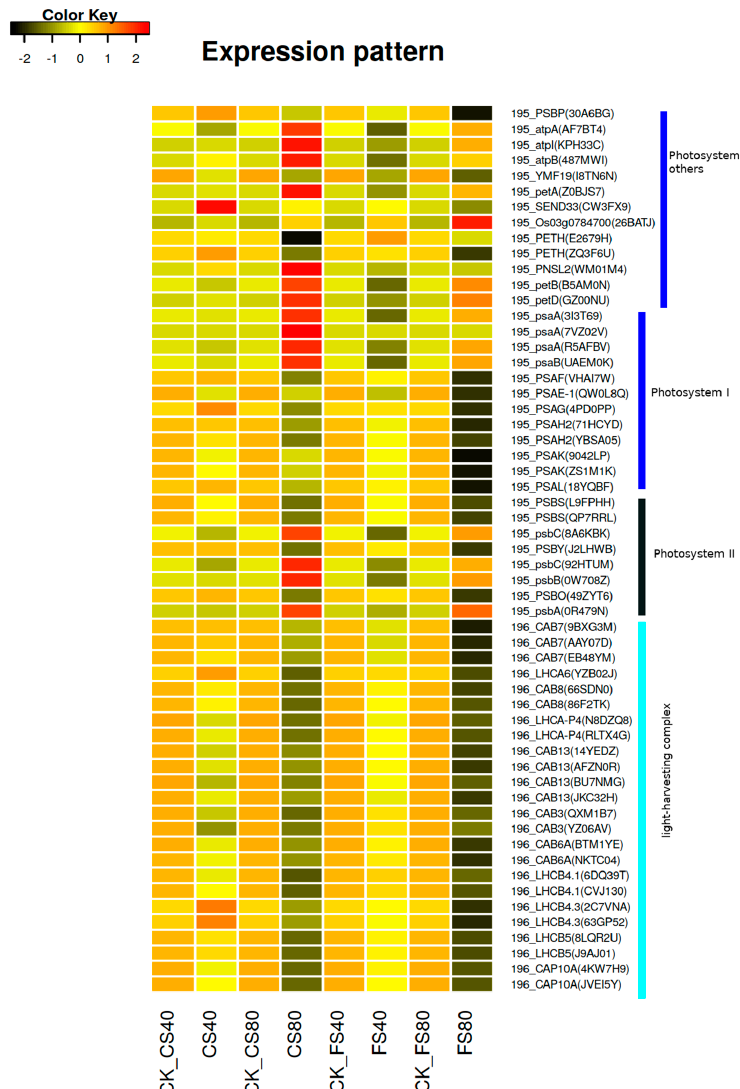
Figure 6. Expression patterns of DEGs induced by shade stress in photosynthesis pathways. The heatmap showing expression levels of differentially expressed genes (DEGs) induced by shade treatments in leaves of peanut plants. The expression level of each gene was calculated as fragment per kilobase per million reads (FPKM) from RNA-Seq data. The color represents the z-score after the transformation of log2(mean FPKM). Each row represents the levels of a DEG and the name of the DEG was listed on the right side of each row. These DEGs involved in the photosynthesis pathway were tagged with a prefix 195 (KEGG map 00195 at https: // www.genome.jp / kegg / pathway / map / map00195.html) and photosynthesis antenna pathway with a prefix 196 (https: // www.genome.jp / kegg / pathway / map / map00196.html). The abbreviation of DEGs listed in Tables 3 and 4 were extracted from KEGG (www.genome.jp / kegg / ) based on the best match to the homologous reference genes in the database KEGG; and corresponding gene id in the peanut genome assembly was listed in parenthesis in the heatmap. FS40, FS80, CS40, and CS80 represent shade treatments of 40% shade at the flowering stage for 30 days, 80% shade at the flowering stage for 30 days, 40% shade from the seeding stage for 30 days to the flowering stage for another 30 days, 80% shade from the seeding stage for 30 days to the flowering stage for another 30 days, respectively. Three experiments were conducted, each with three plants. CK represents control under natural